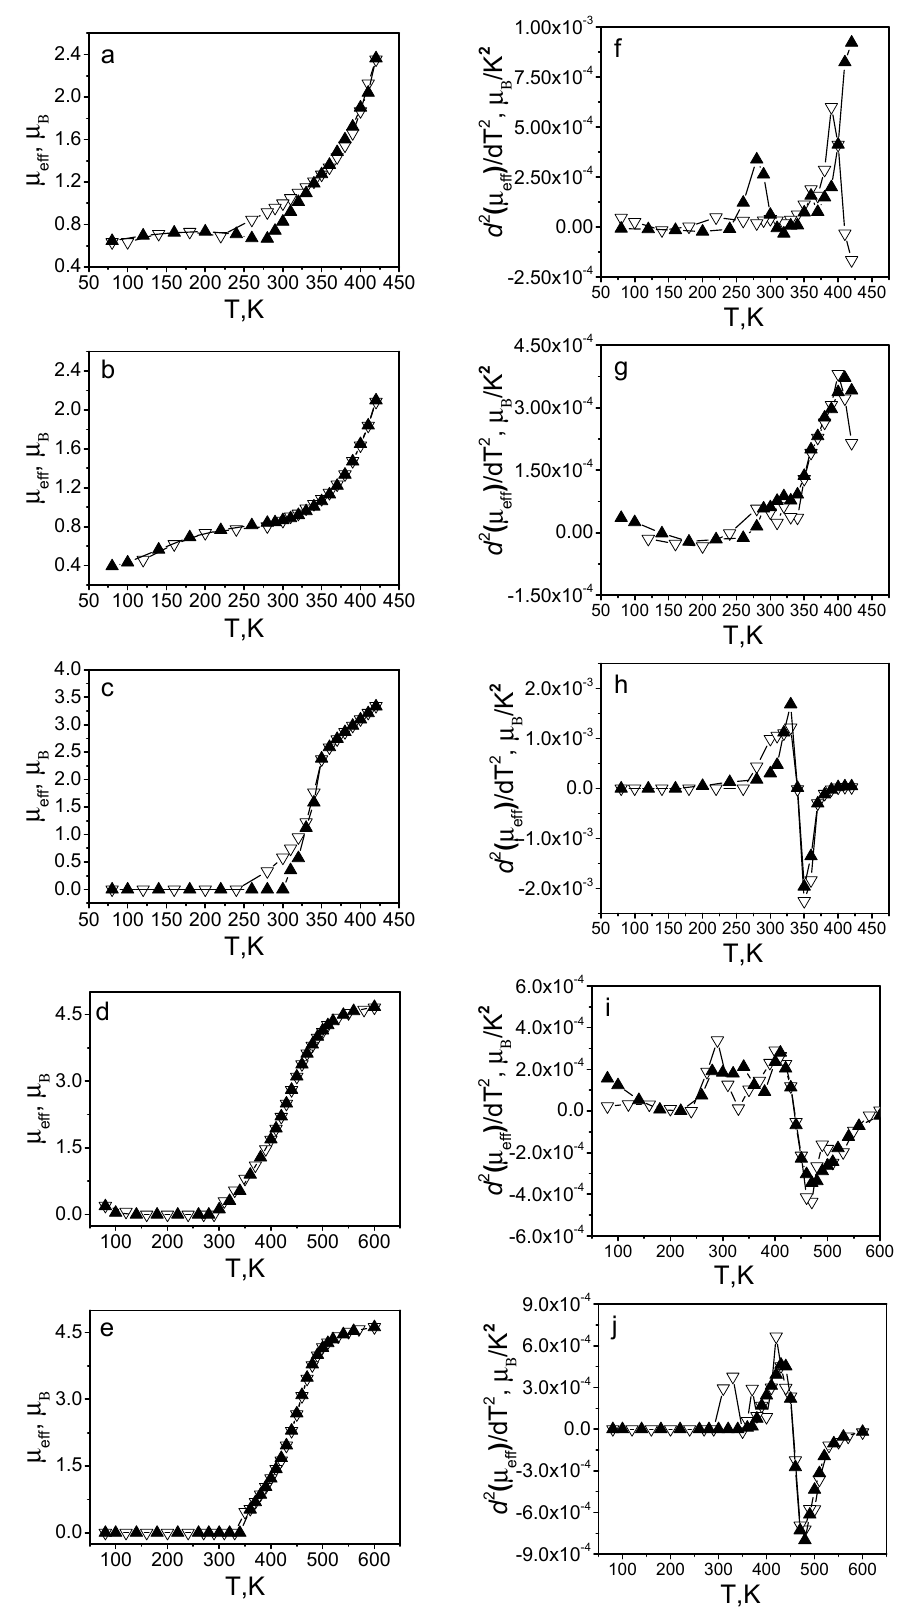
Figure 5. Dependences of μ eff (T) ( a – e ) and d 2 ( μ eff (T))/dT 2 ( f – j ) for 1·0.5H 2 O ( a , f ), 2·H 2 O ( b , g ), 3 ( c , h ), 4·H 2 O ( d , i ), 5·1.5H 2 O ( e , j ). The white and black triangles in the figure correspond to the samples cooling and heating processes respectively. Table 6. The temperatures of direct (T c ↑ ) and inverse (T c ↓ ) SCO for the studied complexes. Complex